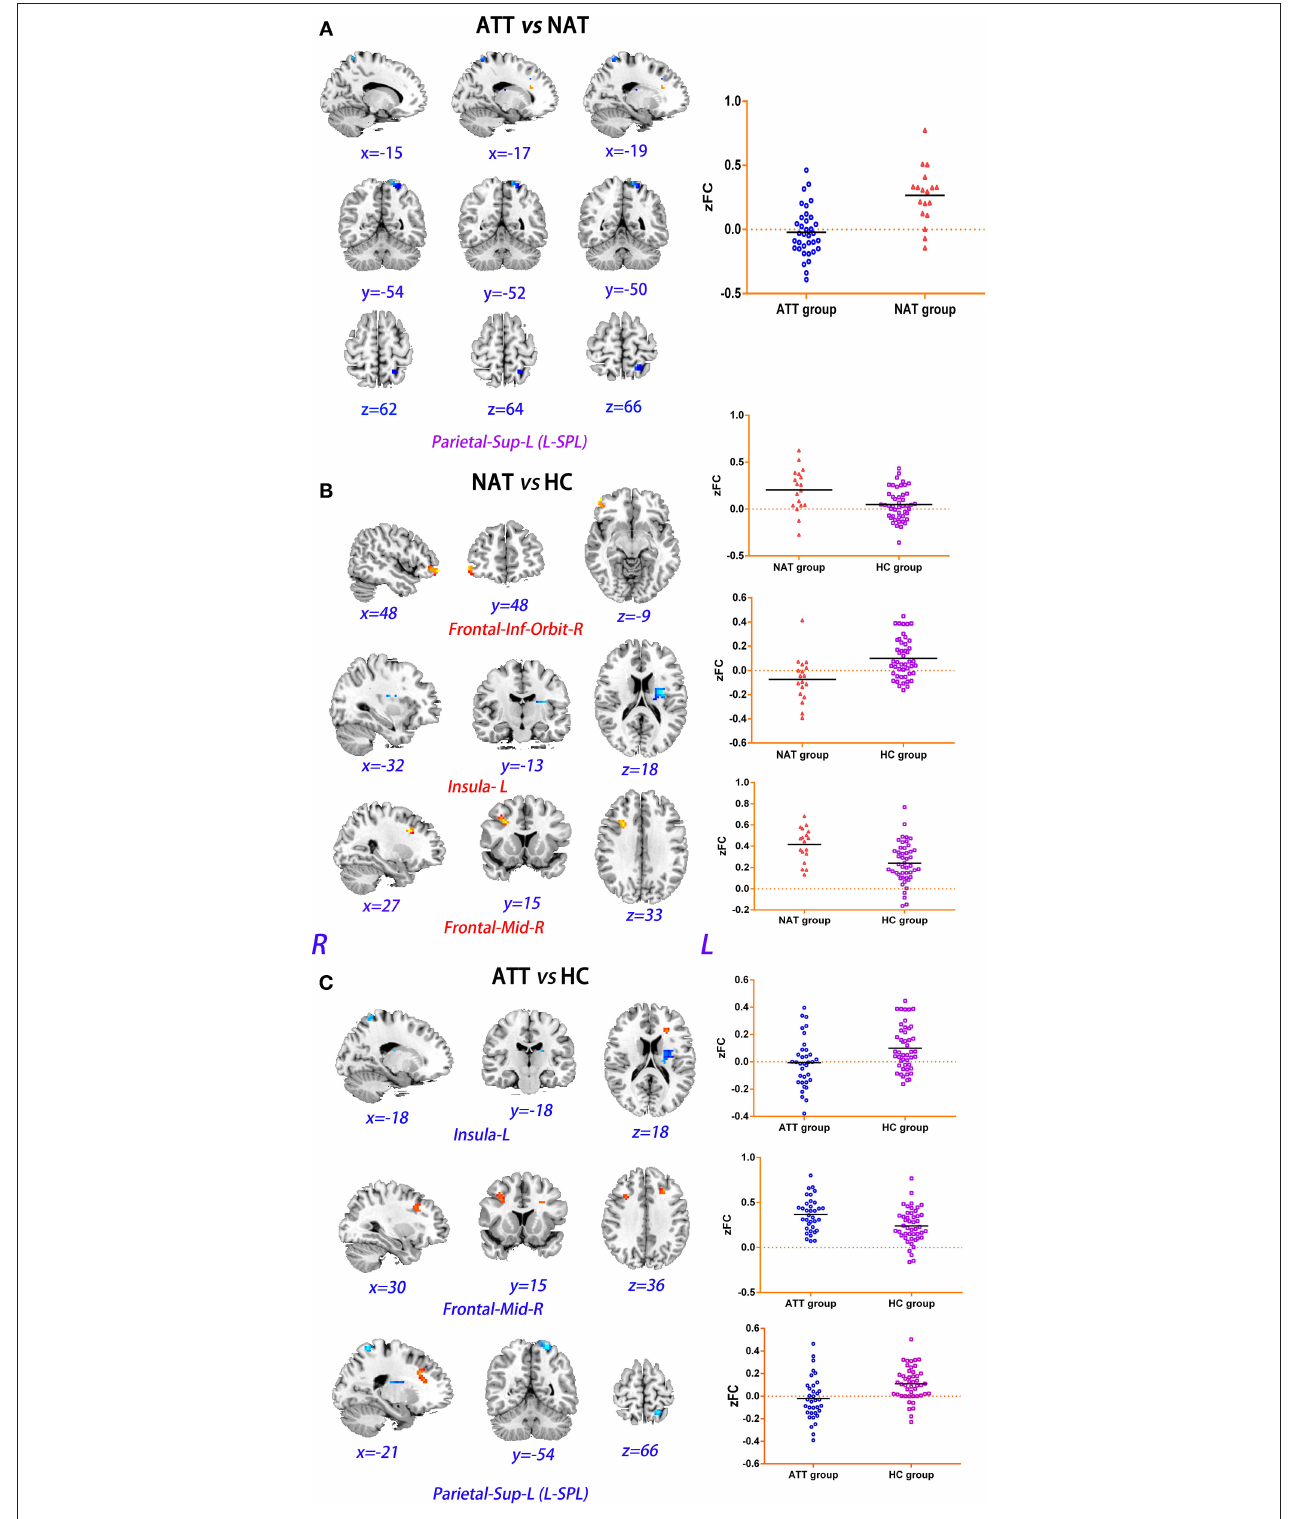
FIGURE 2 | Group differences in RSFC analysis using L-MFG as seed of ROIs. (A) post hoc t -tests revealed that the ATT group demonstrated decreased RSFC between the L-MFG and L-SPG compared to the NAT group (FWE corrected, p < 0.05). (B) Compared to HC group, NAT group showed decreased RSFC of the L-MFG with the left insular cortex, as well as with the right inferior frontal grus and R-MFG (FWE corrected, p < 0.05). (C) Compared to the HC group, the ATT group showed decreased RSFC of the L-MFG with the left insular cortex and L-SPG, and increased RSFC between the L-MFG and R-MFG (FWE corrected, p < 0.05).